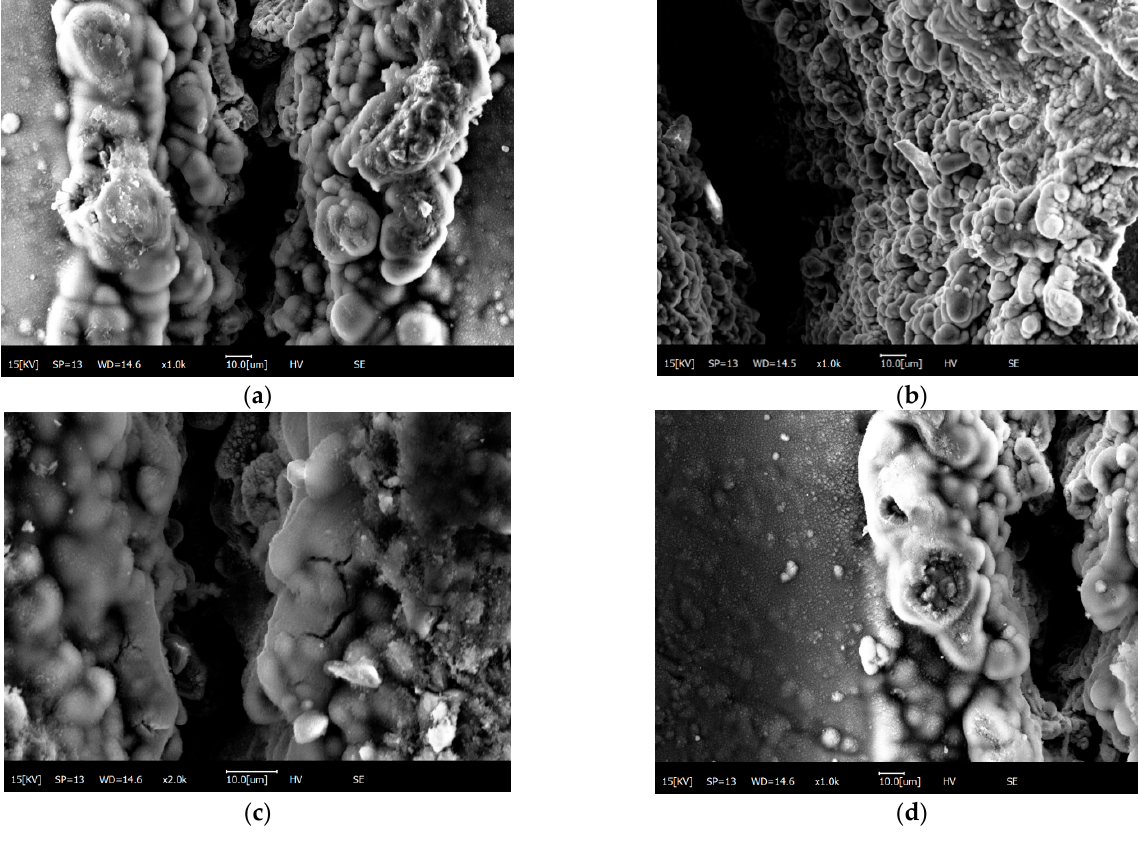
Figure 11. Bonding and fracture of sic particles with molten magnesium alloy. ( a ) SiC and matrix bonded structure; ( b ) The inner walls of the union are aligned; ( c ) Crack in combination; ( d ) Rupture of union.